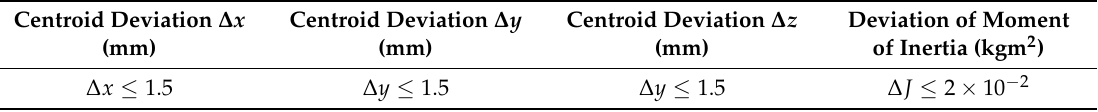
Table 5. The design requirements of measurement system of mass characteristic.